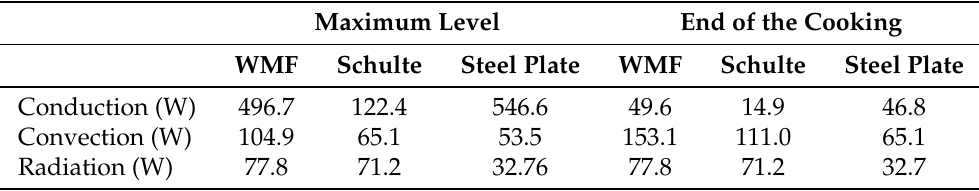
Table 6. Conduction, radiation and convection losses in the three vessels under investigation. The Schulte pan, that has the biggest concavity, presents the lowest conductivity losses during the transient